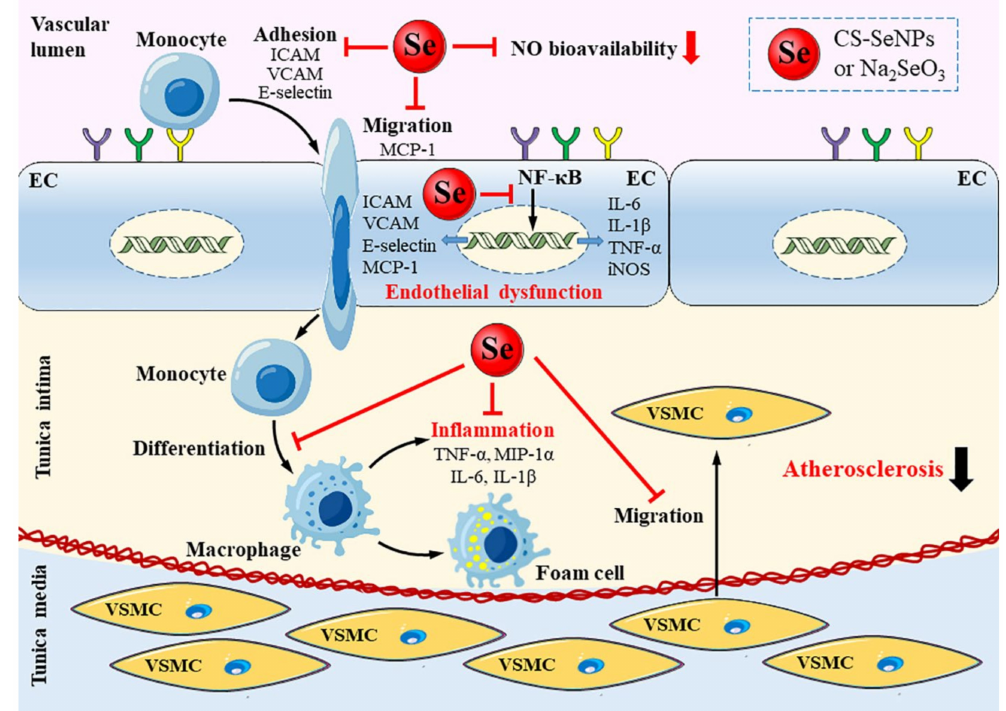
Figure 11. Schematic diagram for the alleviated effect of CS-SeNPs and Na 2 SeO 3 on endothelial dysfunction, inflammation and atherosclerotic lesions. CS-SeNPs and Na 2 SeO 3 suppressed en- dothelial NF- κ B activation and subsequently target gene expression including adhesion molecules VCAM-1, E-selectin and ICAM-1, chemokine MCP-1, cytokines TNF- α , IL-6 and IL-1 β , pro- inflammatory molecule iNOS. Consequently, macrophages recruitment in the intima, the expression of macrophage-derived TNF- α , MIP-1 α , IL-6, IL-1 β , VSMC migration and atherosclerotic lesion formation are